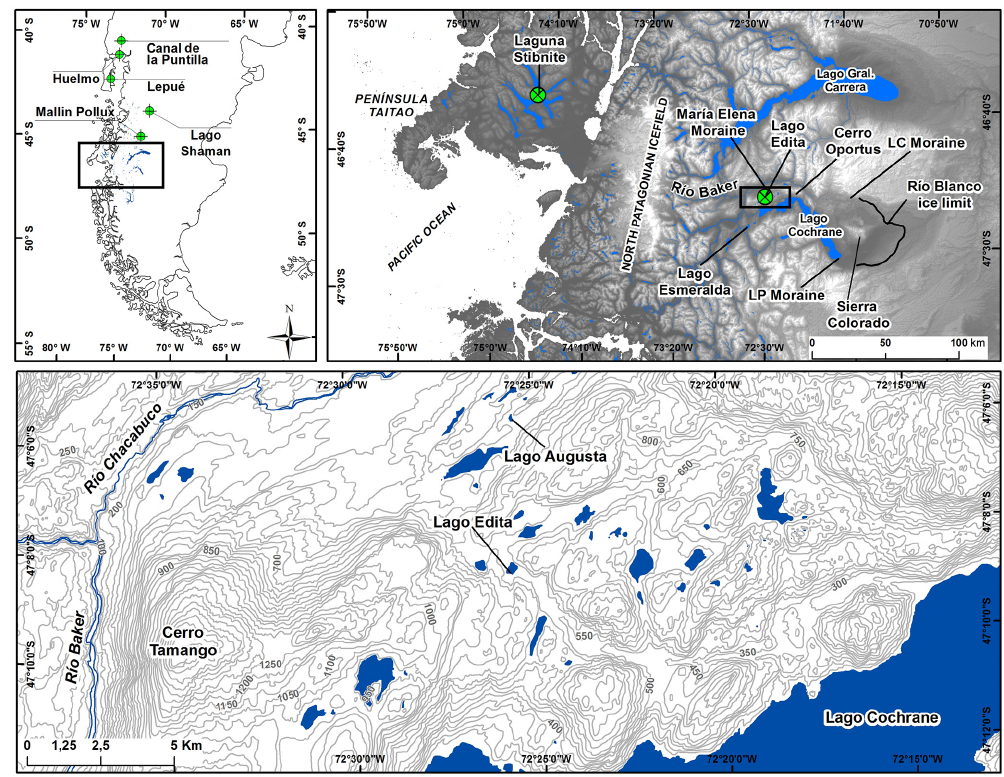
Figure 1. Sketch map of the study area showing the location of central-western Patagonia, the position of Valle Chacabuco relative to the Río Blanco, María Elena, Lago Columna (LC) and Lago Posada (LP) ice limits east Lago Cochrane, and the northern Patagonian ice field and the Taitao Peninsula to the west. We also included Sierra Colorado, Lago Esmeralda and Cerro Oportus for reference. The lower portion of the figure shows a detail on the Cerro Tamango area and the portion of Valle Chacabuco where Lago Edita and Lago Augusta are located. Also shown are palynological sites discussed in the main text (Canal de la Puntilla, Huelmo, Mallín Lago Shaman, Mallín Pollux, Lago Stibnite, Lago